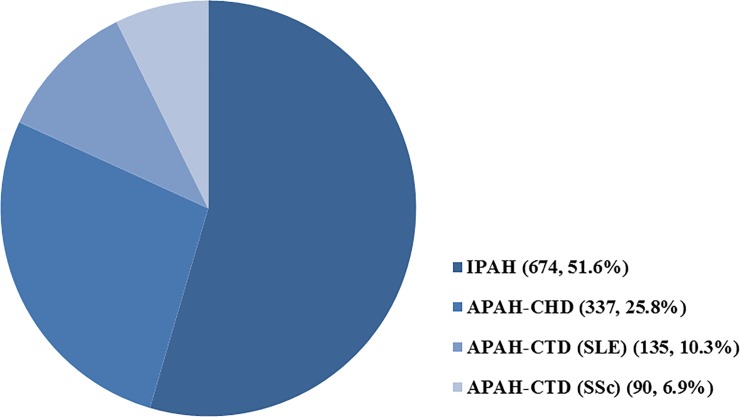
Pulmonary arterial hypertension etiological breakdown of patients at enrolment.